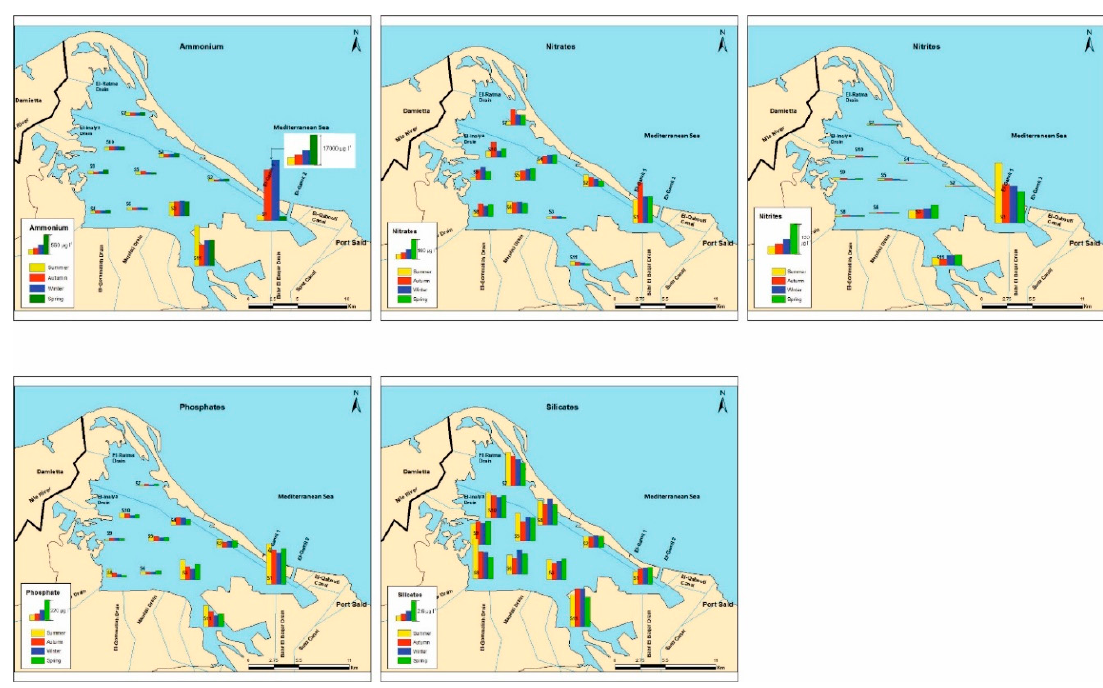
Figure 3. Spatiotemporal variations of nutrients in Lake Manzalah.